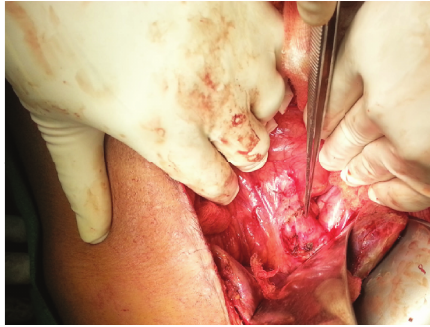
Figure 1: Perforation on the anterolateral surface of the common bile duct.